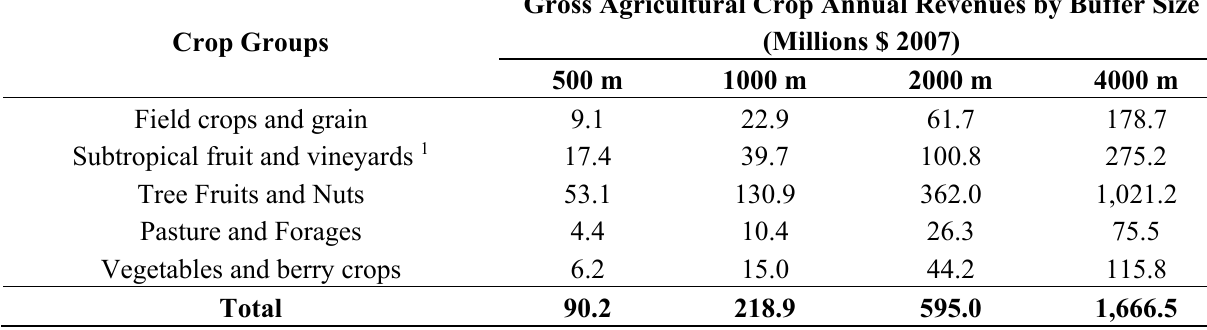
Table 4. Estimated agricultural value for various land use buffer sizes, using crop and yields from the SWAP model